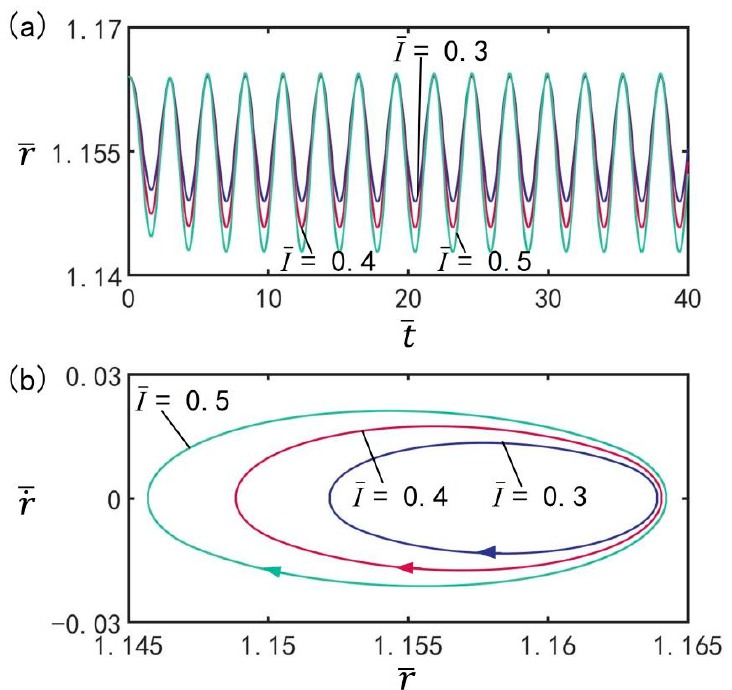
Figure 6. The effect of light intensity I on the light-powered beating of LCE balloon. ( a ) Time histories;